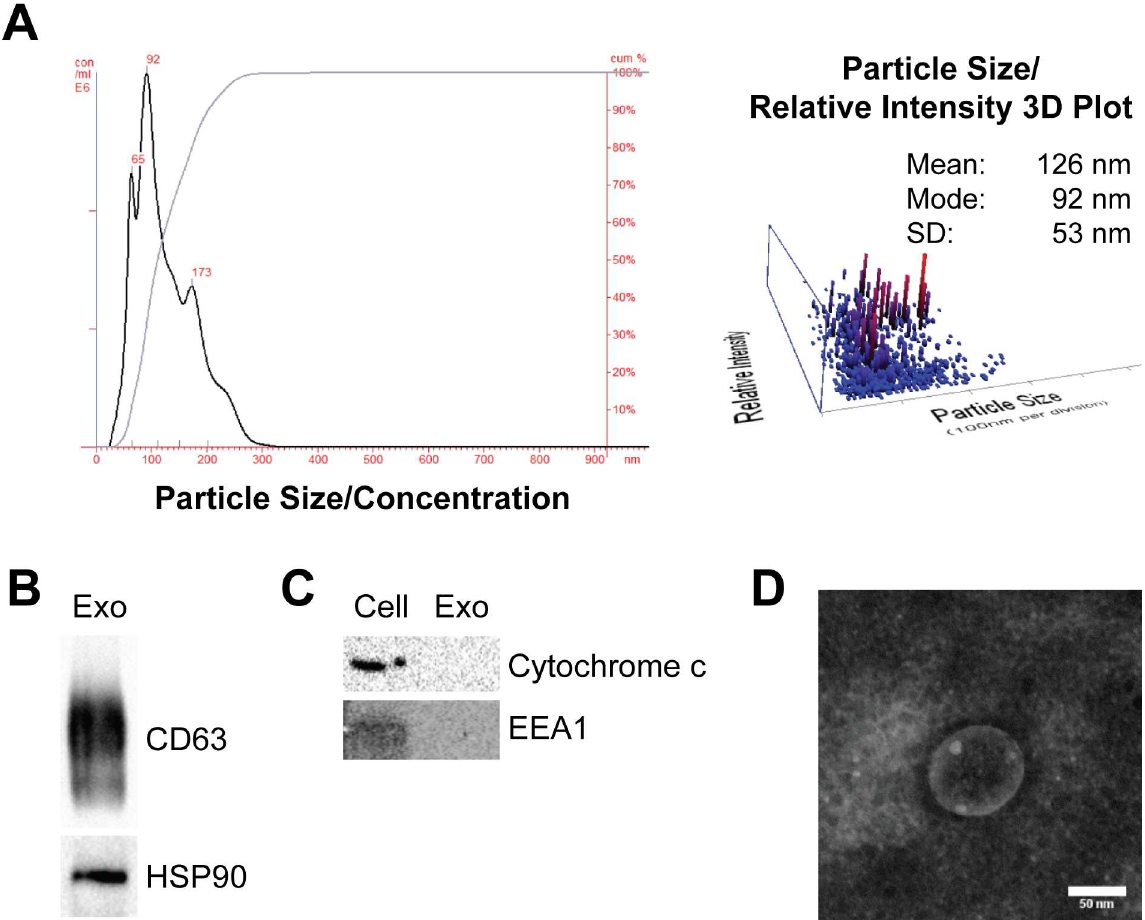
Fig 2. Characterization of CDC-derived exosomes. (A) Nanoparticle analysis of particle distribution profile shows human CDC derivedexosomes largely range between 65 and 173nm in diameter. (B) Immunoblot analysis of exosomalmarkers CD63 and HSP90 in CDC derived exosomes and (C) non-exosomal makers, cytochrome c and EEA1, in exosomes and corresponding CDC whole-cell lysate (15 μ g/well).(D) Transmission electron microscope image of human CDC-secreted exosome at 100 keV. Negative contrast staining showingtypical exosome